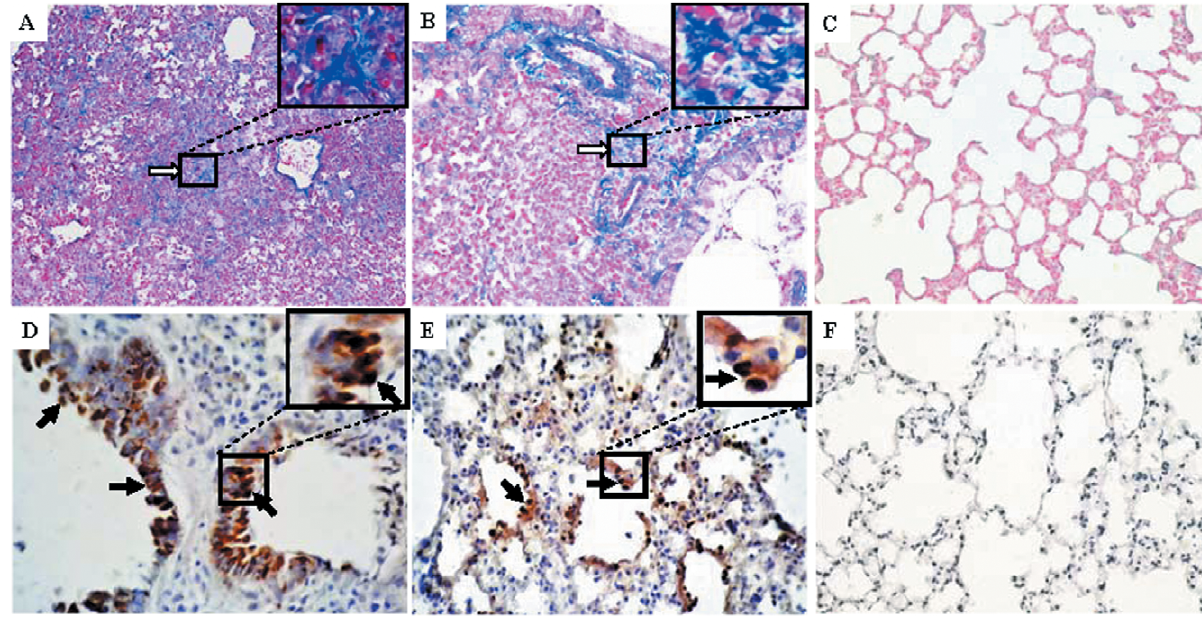
Figure 3. Masson’s trichrome stained sections (A–C) and immunohistochemical staining for influenza A nucleoprotein (D–F) of the SD/09-infected mouse lung. Alveoli were collapsed and filled with collagen fibers (A, B, open arrows); normal mouse lungs (C). Influenza A nucleoprotein (brown) in the epithelial cells of the bronchioles (D, solid arrows); viral nucleoprotein in abundant terminal bronchioles epithelial cells and few alveolar epithelial cells (E, solid arrows); normal mouse lungs (F). Magnification: A, 6 100; B, C, D, E and F, 6 400.